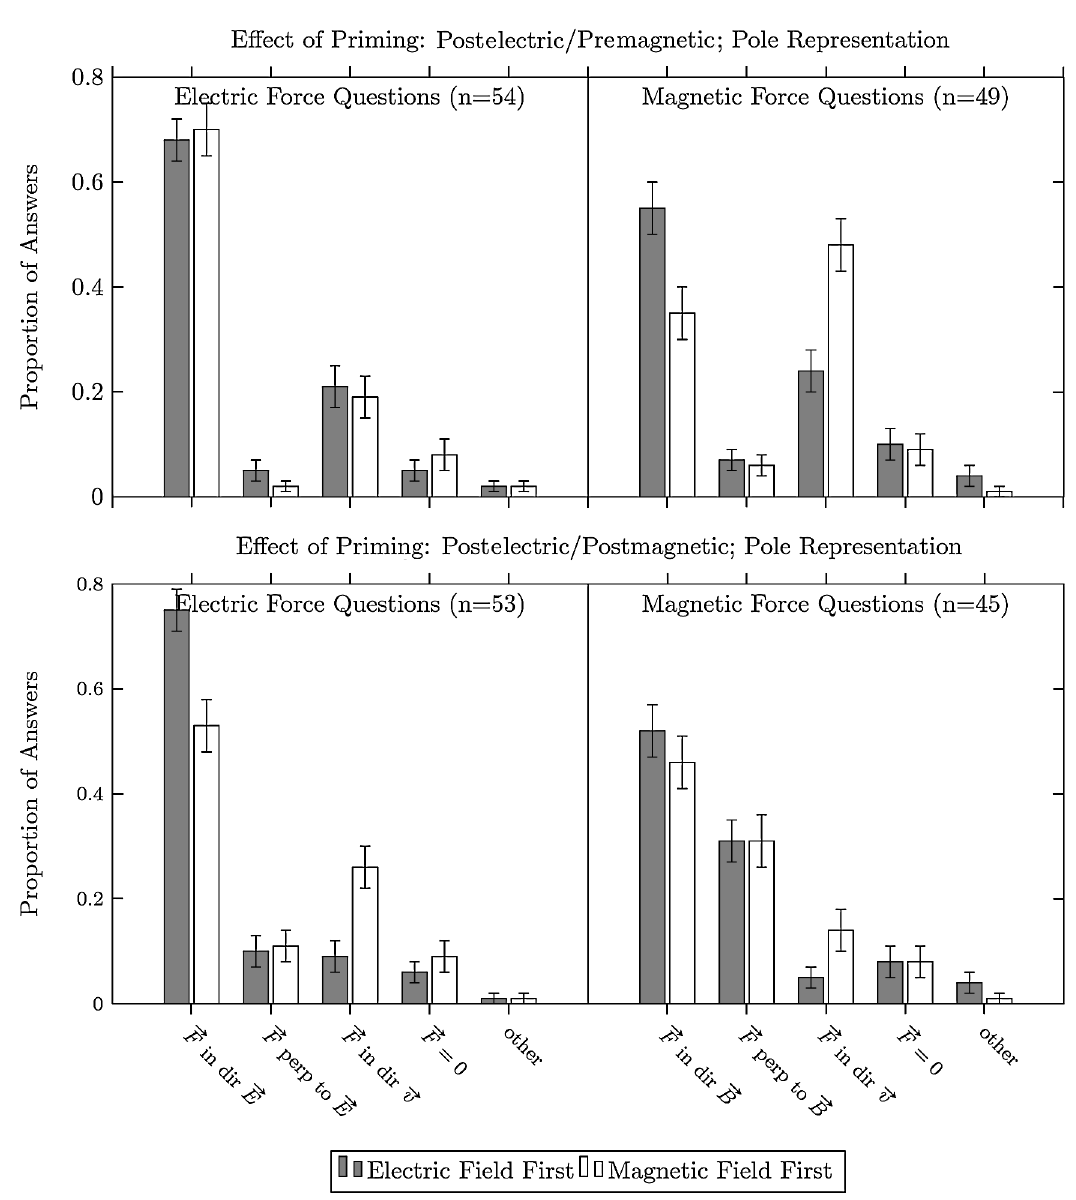
FIG. 8. Student responses showing the effect of question order (or cognitive priming ) on the pole